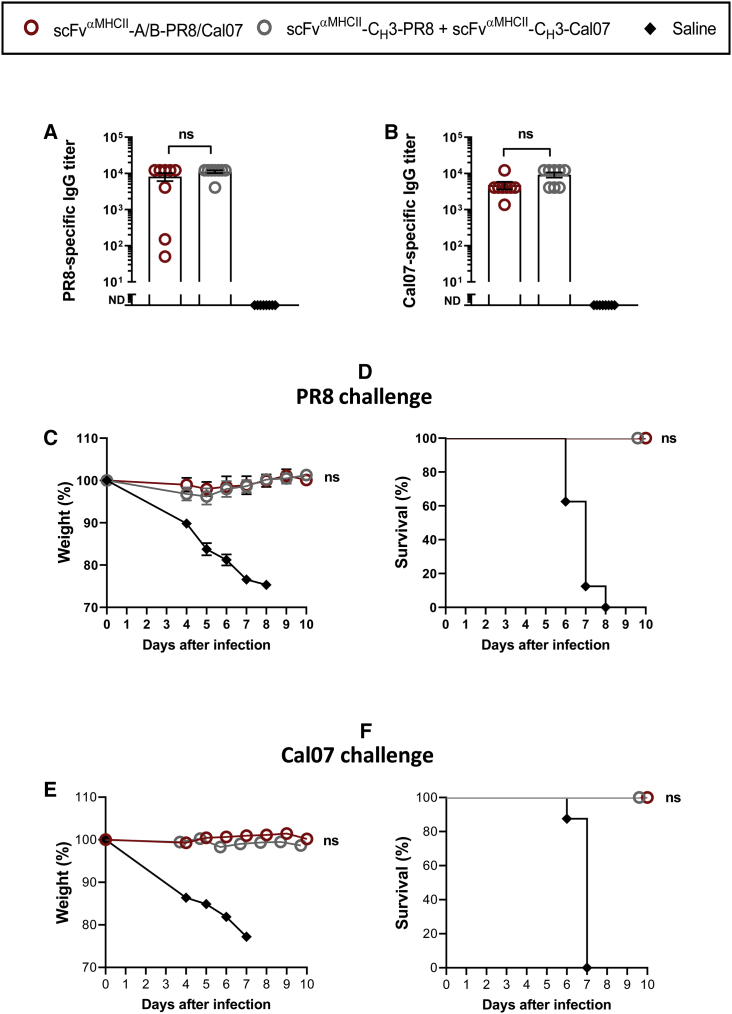
Comparison of A/B Heterodimeric and CH3-Homodimeric DNA Vaccines Expressing Two Different HAsBALB/c mice were vaccinated i.m./EP with 100 μg of DNA (two plasmids) encoding either A/B heterodimeric or CH3 homodimeric vaccine proteins that express HA from both PR8(H1N1) and Cal07(H1N1) as indicated. Mice were boosted after 5 weeks. (A and B) Levels of PR8-specific IgG (A) and Cal07-specific IgG (B) serum antibodies 2 weeks after the boost (mean ± SEM; **p < 0.01 Mann Whitney; ND, not detectable). (C and E) 2 weeks after the boost, the mice were infected with a lethal dose of PR8 (C, 5 × LD50), or Cal07 (E, 5 × LD50) influenza virus. Weight was followed for 10 days. Weight loss of 20% was defined as the humane endpoint, at which time point the mice were euthanized (n = 8/group, mean ± SEM; Mann-Whitney test, *p < 0.05, **p < 0.01; ns, not significant). (D and F) Survival curves of the vaccinated mice after challenge with either PR8 (D) or Cal07 (F) influenza virus.